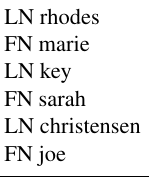
Table 3. Input for Example 4. Table 4. Input for Example